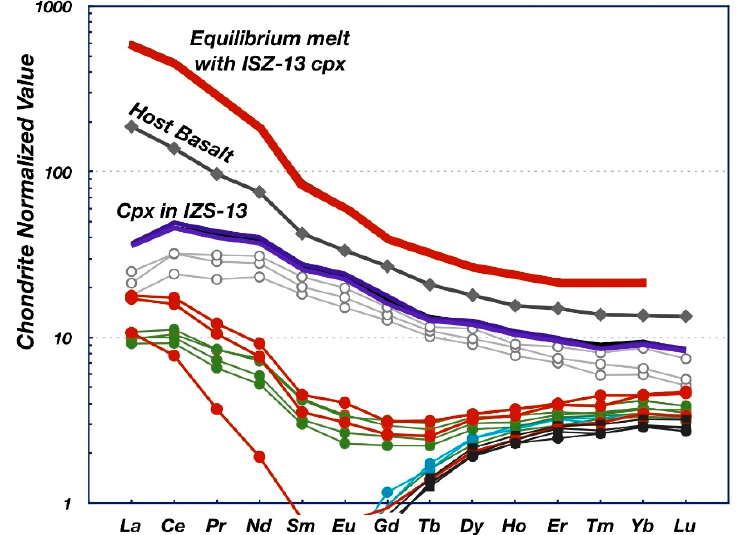
Figure 13. Chondrite-normalized REE pattern of the melt in equilibrium with clinopyroxene in a metasomatized Bankawa lherzolite, based on partition coefficients of Brunelli et al. [97]. The lherzolite (IZS-13) contains the clinopyroxene with the highest REE contents, and is expected to be the highest degree of metasomatism. Note the melt responsible for the metasomatism is very similar in REE pattern to the host alkali basalt.